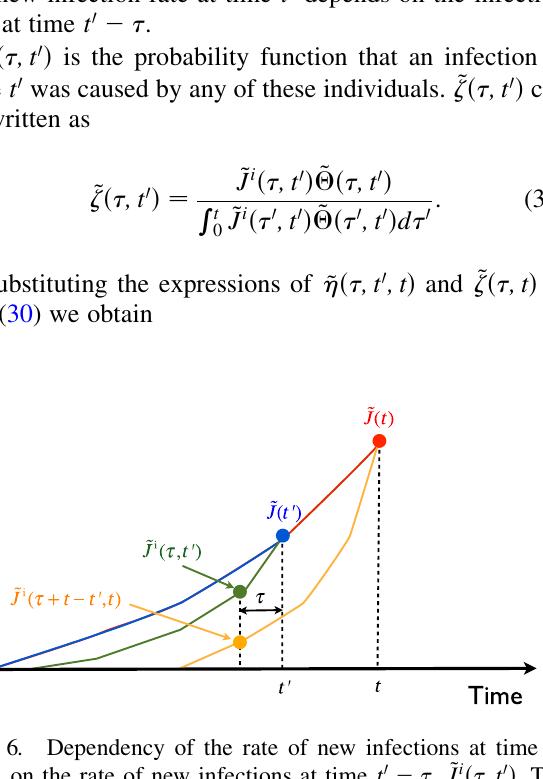
~ J i ð (cid:2); t 0 Þ . The